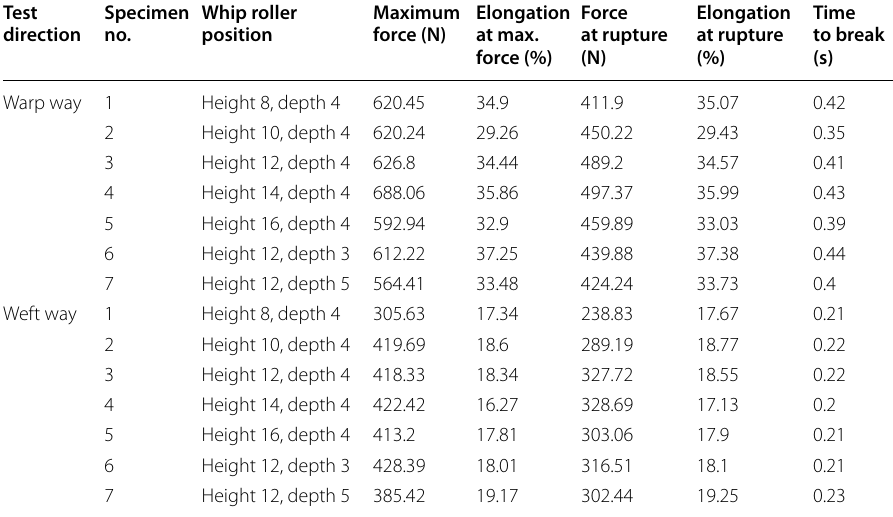
Table 6 Tensile strength test results in grab method for finished fabric in warp and weft way Test Specimen direction